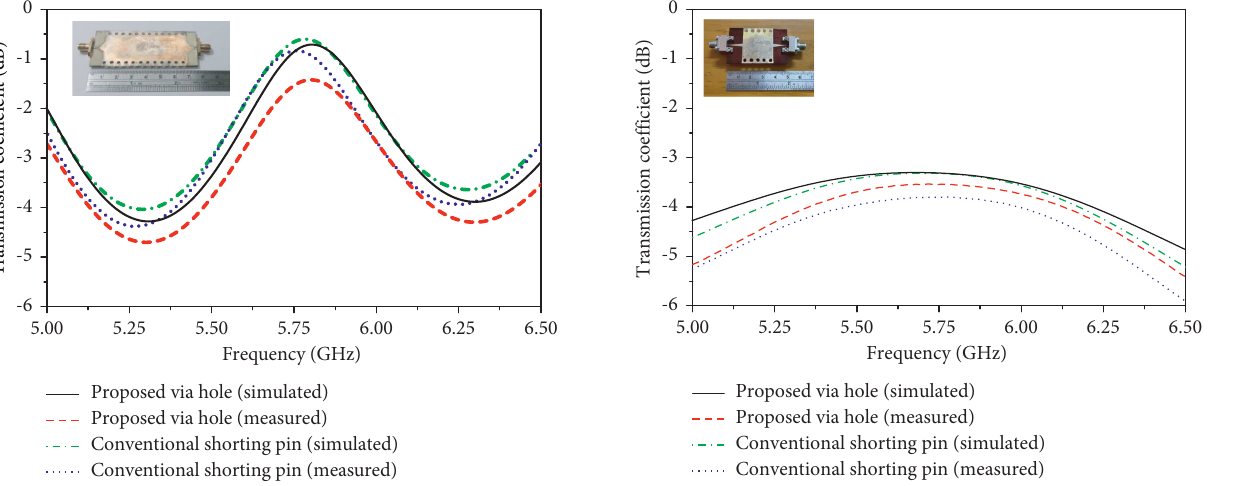
Figure 5: Transmission coefficient resulting from the via hole and shorting pin fabricated on the RO 4003C substrate.